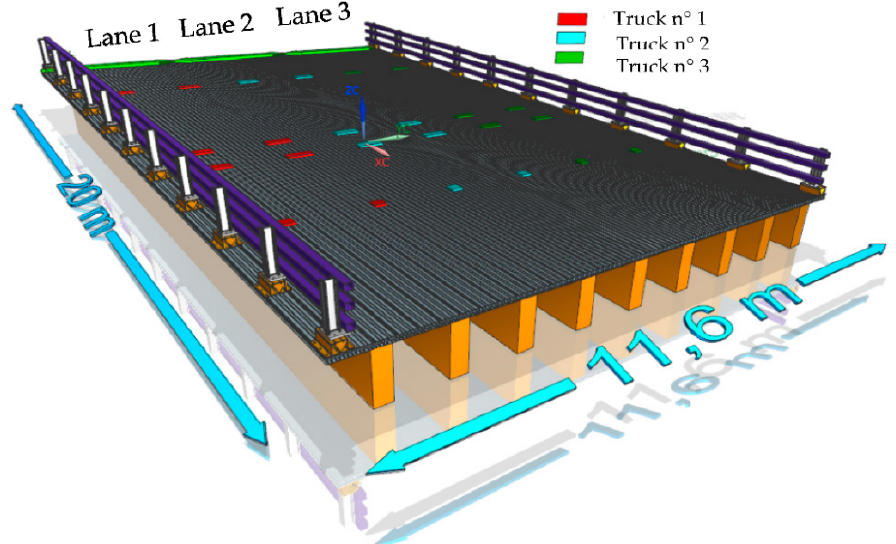
Figure 4. Spatial arrangement of the CL-625 truck live loads (wheel and axle loads) on the three lanes.